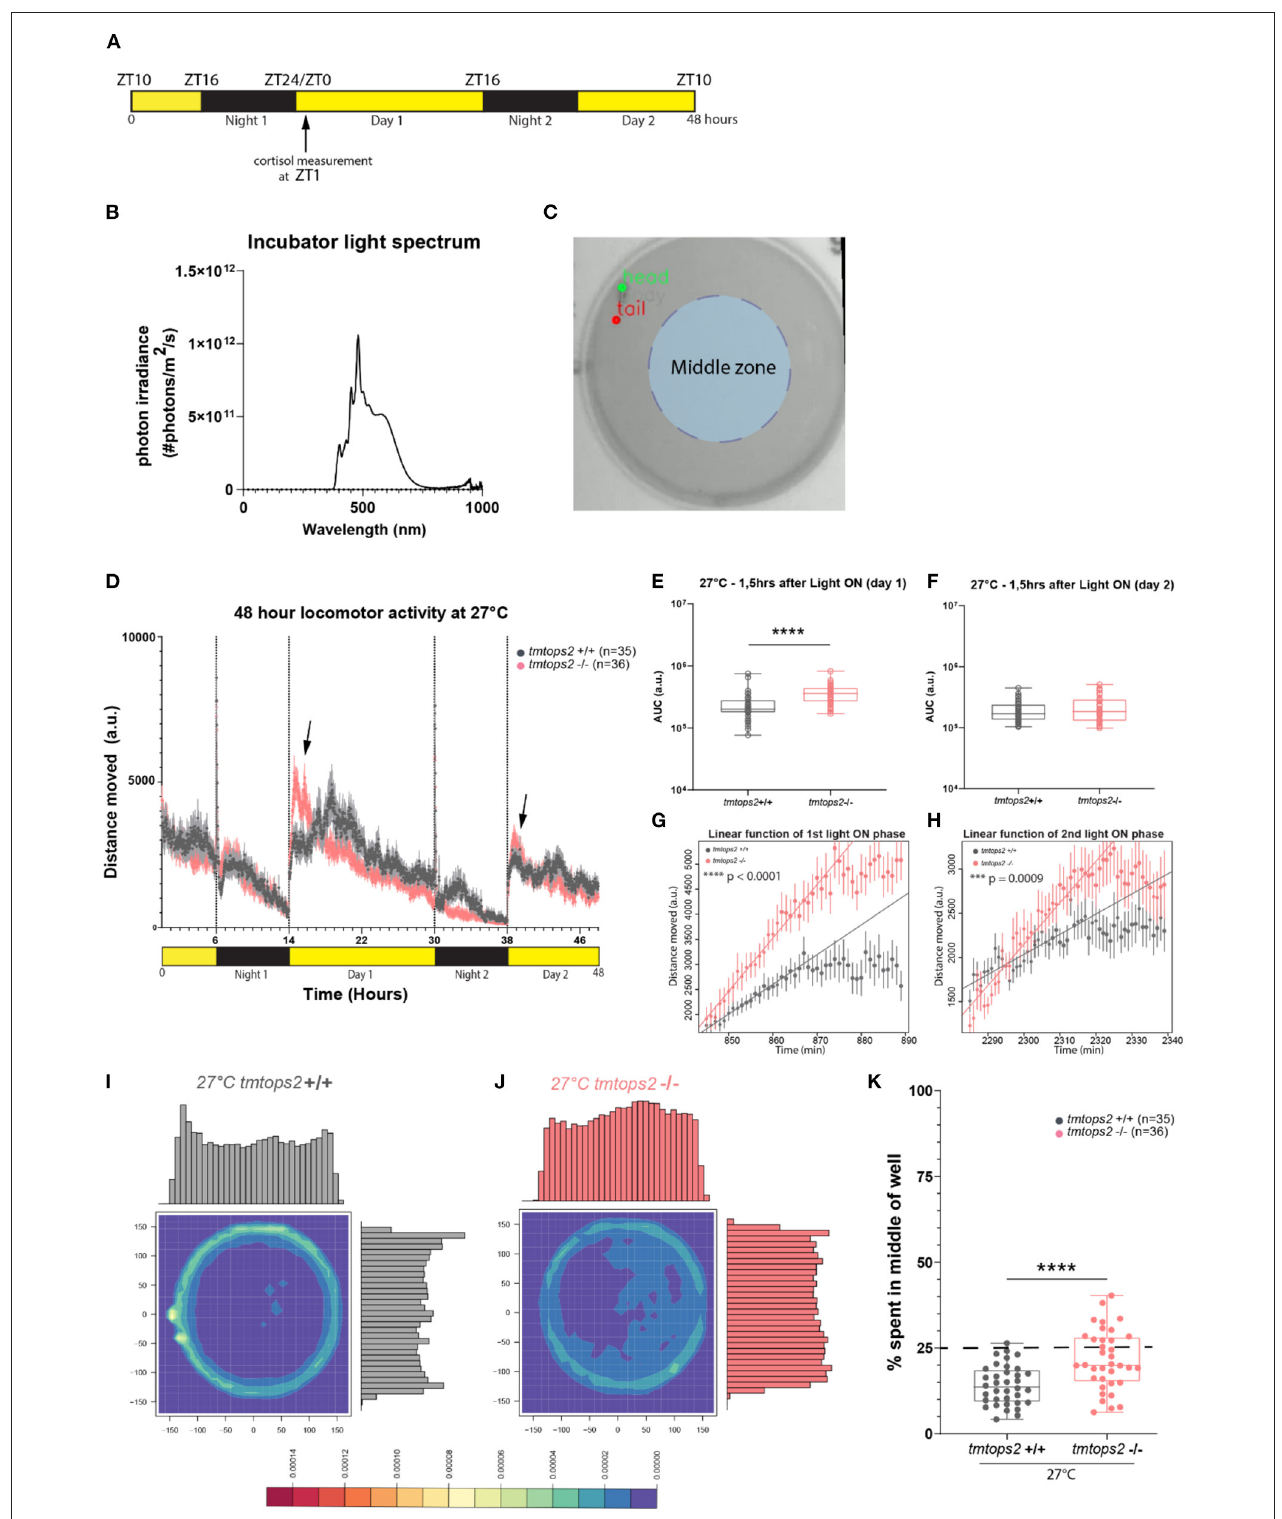
FIGURE 1 | Experimental design and locomotor activity characterization at 27 ◦ C. (A) Schematic representation of the experimental design within the behavioral setup: 16-h light/8-h dark (L/D) regime. For cortisol measurements, larvae were sacrificed at ZT1 (arrow). (B) Light spectrum was used for all the experiments. (C)